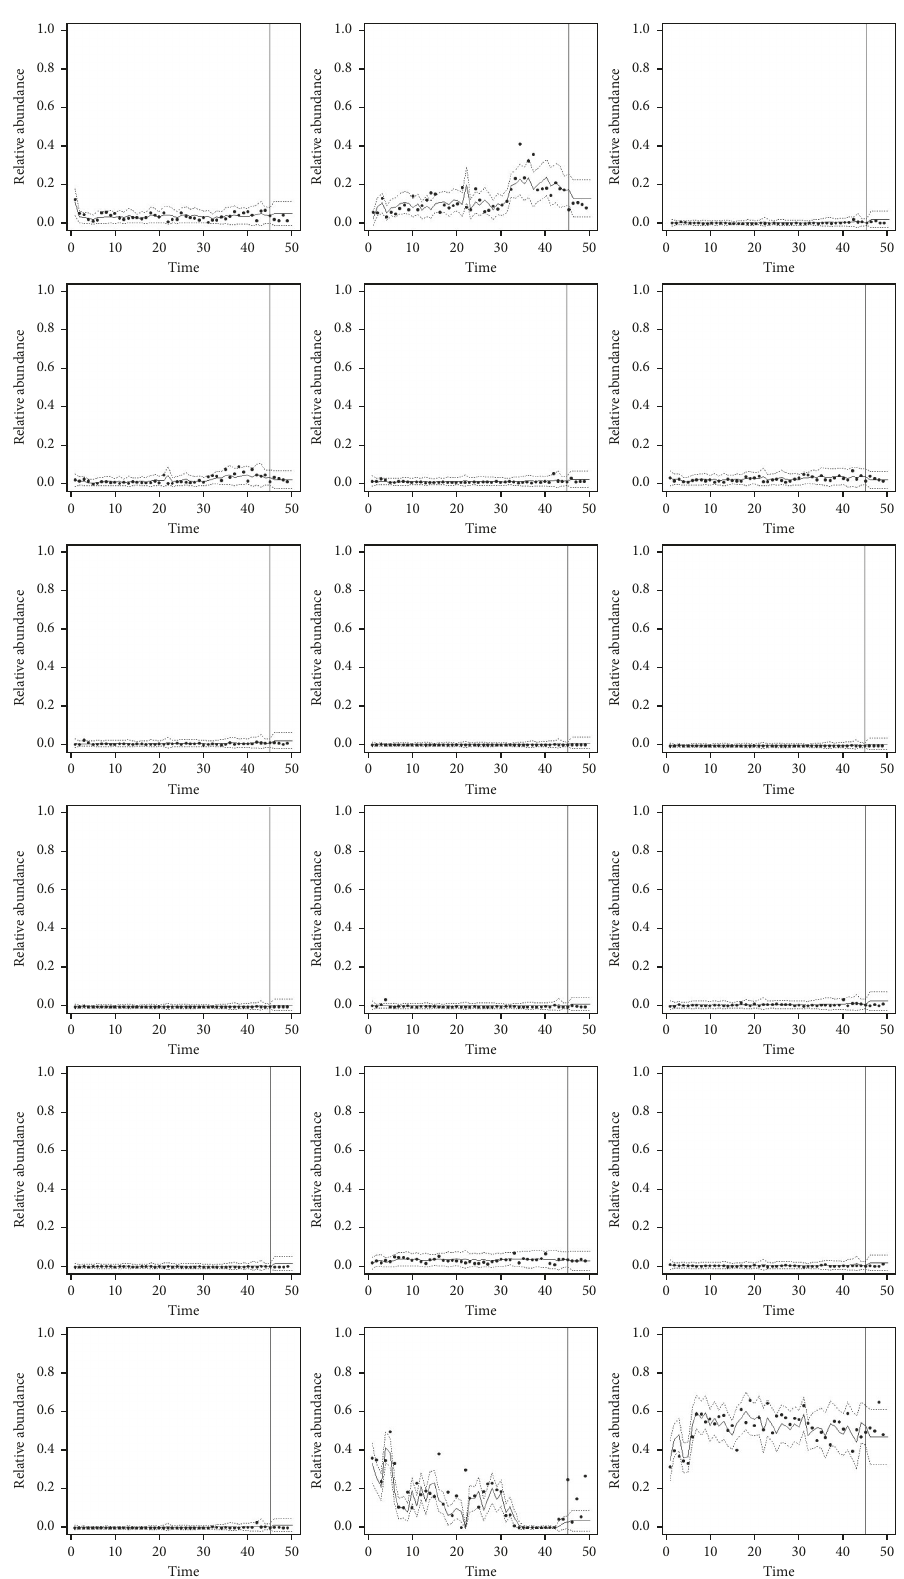
Figure 3: Model estimation and prediction of the female dataset at genus taxonomic level. Black points represent the data, the black line represents the expected value obtained with the proposed model, and dashed lines represent the value of E black line represents when the estimation of the model finishes and the prediction starts. The genera are, from left to right, o_bacteroidales;f_; g_ , other, o_clostridiales;f_;g_ , f_lachnospiraceae;g_ , g_blautia , f_lachnospiraceae;g_clostridium , g_coprococcus , g_dorea, g_eubacterium